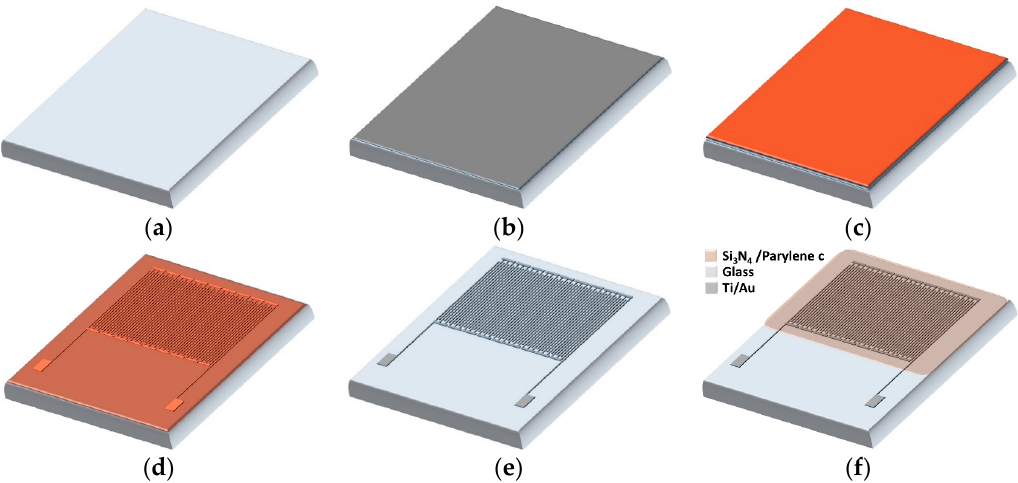
Figure 1. Fabrication of capacitive sensing element: ( a ) Clean glass substrate; ( b ) Sputtering of 10 nm Ti and 400 nm Au; ( c ) Photoresist coating; ( d ) Patterning of photoresist; ( e ) Photoresist develop, dry etching, and photoresist removal ( f ) Dielectric deposition S i3 N 4 (50 nm)/Parylene C (300 nm).